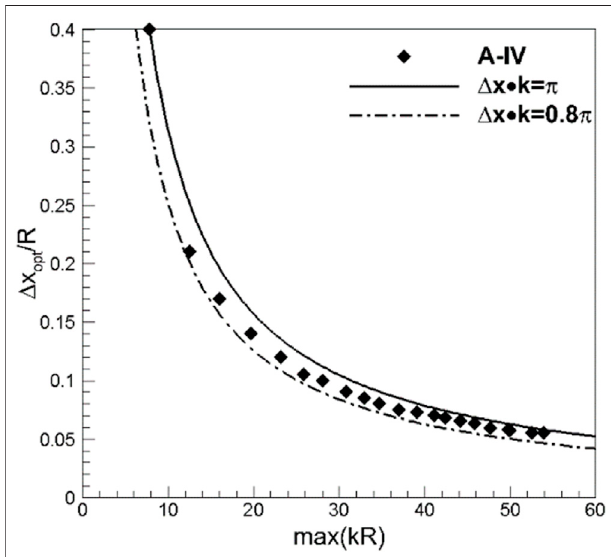
FIGURE8| Lawofoptimalaxialspacingappliedinarrayschemedesign.